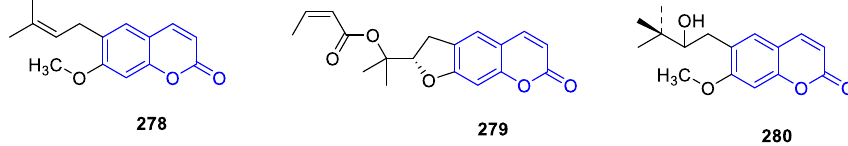
Figure 11. Chemical structures of the isolated coumarins from rhizomes of Ferula gotrachycarpa Boiss ( 277 – 280 ).